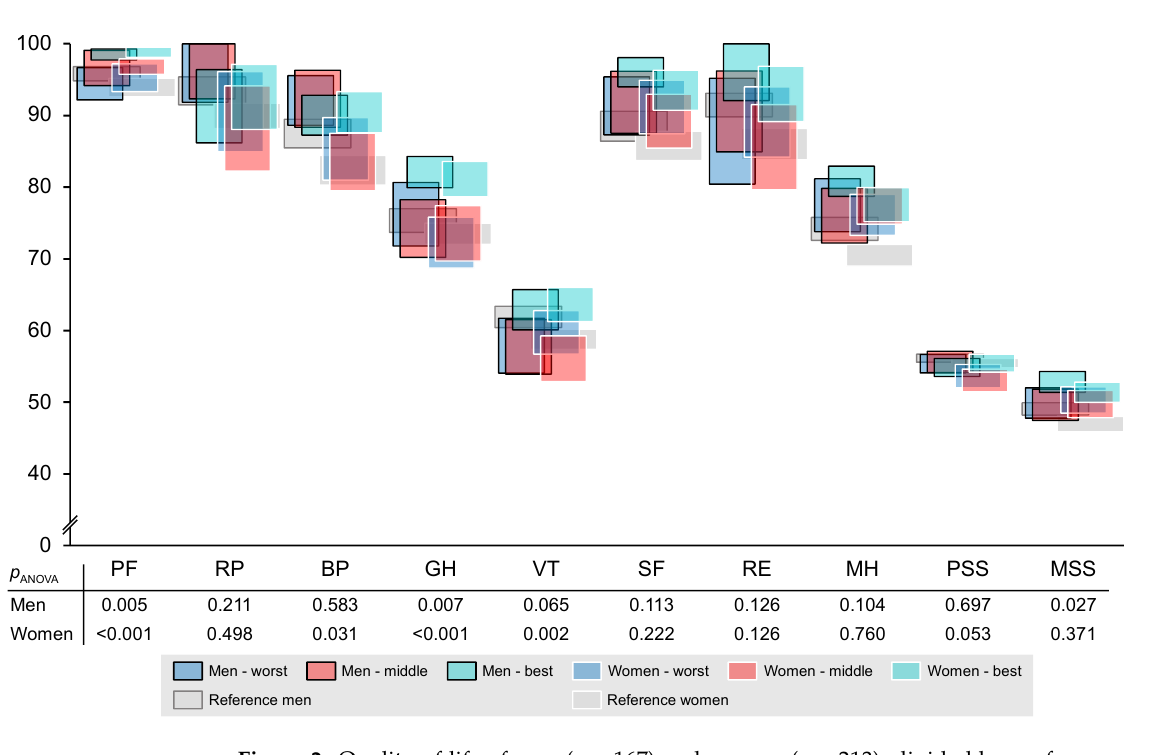
Figure 2. Quality of life of men ( n = 167) and women ( n = 213), divided by performance groups. Displayed are 95% confidence intervals. PF: physical functioning; RP: role physical; BP: bodily pain; GH: general health; VT: vitality; SF: social functioning; RE: role emotional; MH: mental health; PSS: physical sum score; MSS: mental sum score; p ANOVA : p -value of ANOVA between groups.